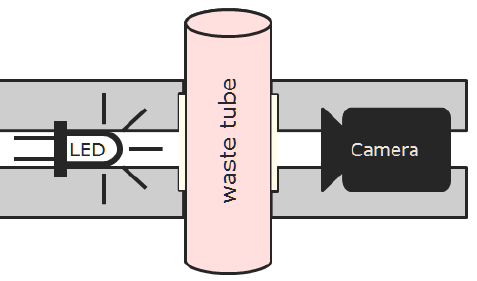
Figure 7. Schematic representation of the sensor. On the left side, an LED exerts light that is transmitted through the tube filled with irrigation waste fluid. The transmitted light is captured by a camera. The bright squares next to the tube represent thin glass plates that can be inserted into the optical pass to seal the LED and the camera and to enable effective cleaning and disinfection in clinical application. Table 1. Listing of hardware resources used for bubble detection and MIPI interface on the FPGA. Two different implementations of the bubble detection network are given: one that complies with the current specifications regarding frame rates as well as a maximum performance version. Please note that the standard version leaves sufficient space to realize a MIPI interface to directly connect the